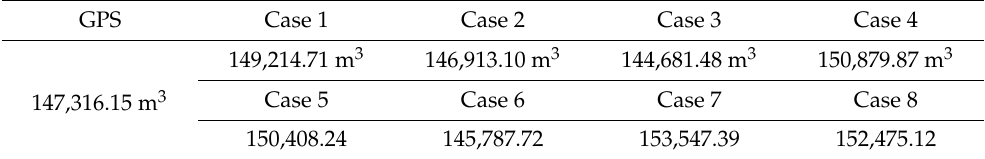
Table 4. Earthwork volume calculation result using the UAV.